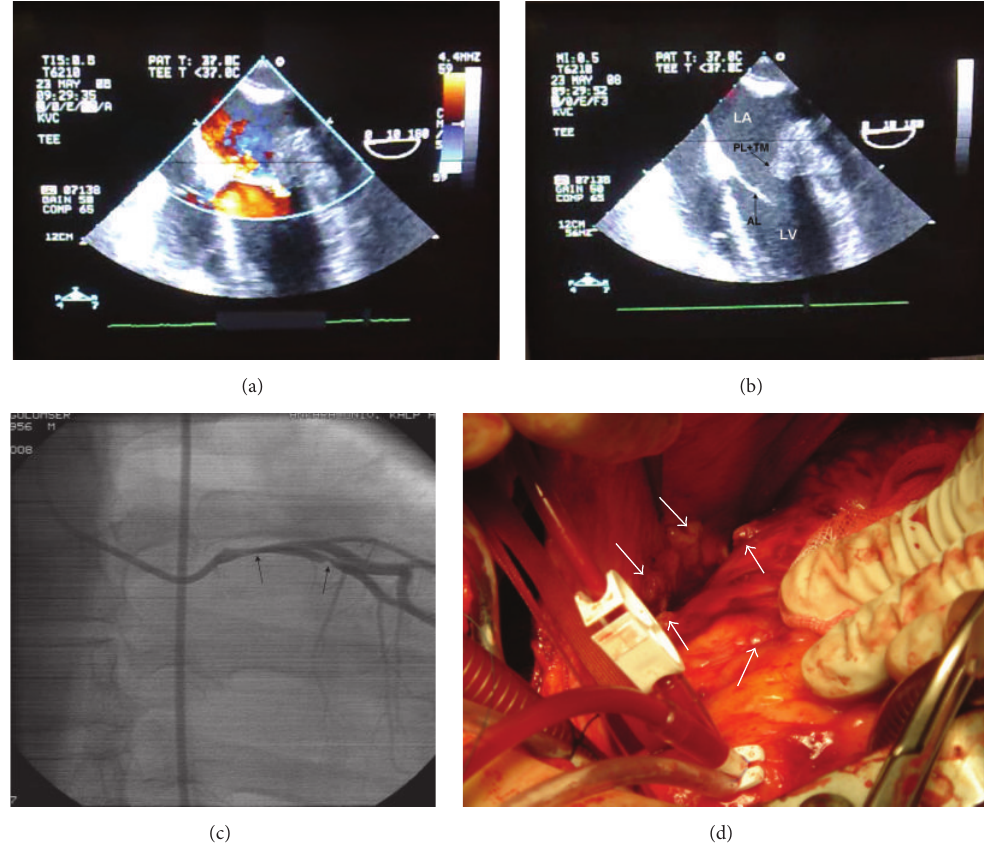
Figure 1: ((a) and (b)) Transesophageal echocardiogram midesophageal 4-chamber view at 0 ∘ . (a) Color Doppler image shows severe (III/IV) mitralregurgitation.(b)Thetwo-dimensionalimageshowsanechogenicmassintheleftatrium,arisingfromtheregionoftheposteriormitral leaflet and causing restriction of the movements of this leaflet. (c) Coronary angiogram (left anterior oblique view with caudal angulation) showing significant stenoses at the left main (70%) and circumflex (80%) arteries (arrows). (d) Intraoperative view of the pericardial space. Extensive and multiple masses in the pericardium and multifocal central hemorrhage in the epicardium are